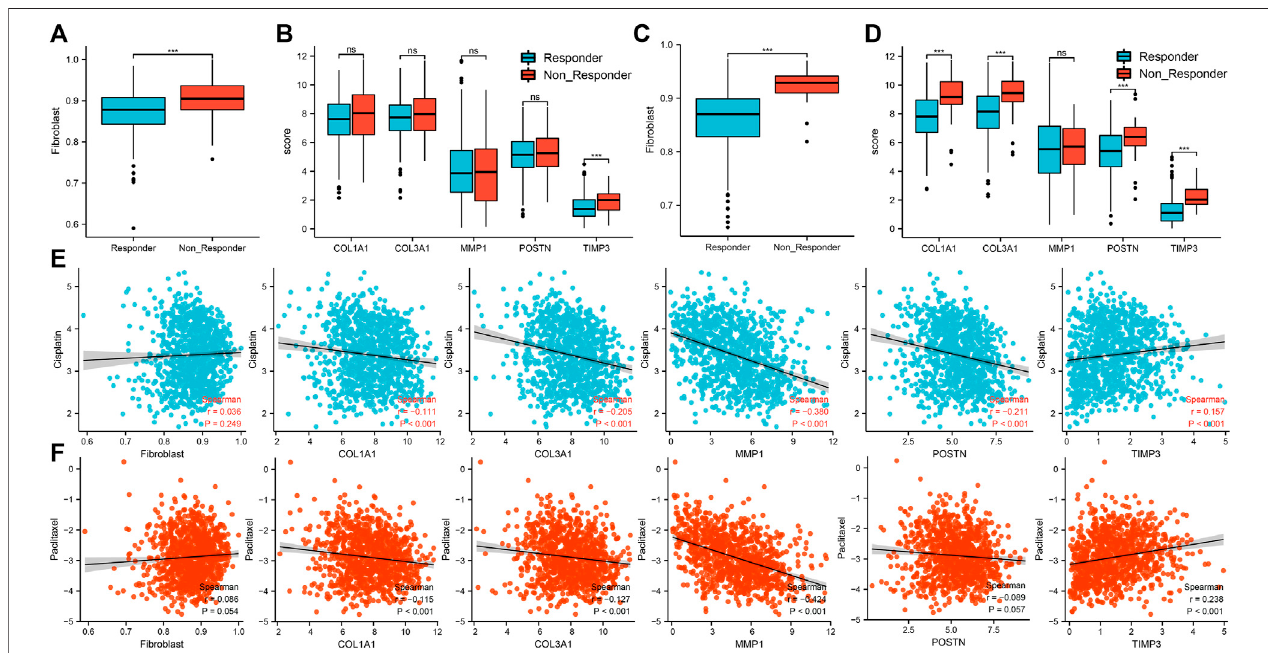
FIGURE 8 | Association between the fi ve hub genes and response to immunotherapy and chemotherapy. Notes: (A) : The difference of cancer-associated fi broblastsin fi ltration level between immunotherapy responder and non-responder patients based on the TCGA-LUAD cohort, ns = p > 0.05, * = p < 0.05, ** = p < 0.01, ***= p < 0.001; (B) :Thedifference ofhubgeneexpression betweenimmunotherapyresponder andnon-responderpatientsbasedontheTCGA-LUADcohort, ns= p > 0.05, * = p < 0.05, ** = p < 0.01, *** = p < 0.001; (C) : The difference of cancer-associated fi broblasts in fi ltration level between immunotherapy responder and non- responder patients based on the TCGA-LUSC cohort, ns = p > 0.05, * = p < 0.05, ** = p < 0.01, *** = p < 0.001; (D) : The difference of hub gene expression between immunotherapy responder and non-responder patients based on the TCGA-LUSC cohort, ns = p > 0.05, * = p < 0.05, ** = p < 0.01, *** = p < 0.001; (E) : Correlations between cancer associated fi broblasts, fi ve hub genes and response to cisplatin in NSCLC patients; (F) : Correlations between cancer associated fi broblasts, fi ve hub genes and response to paclitaxel in NSCLC patients.